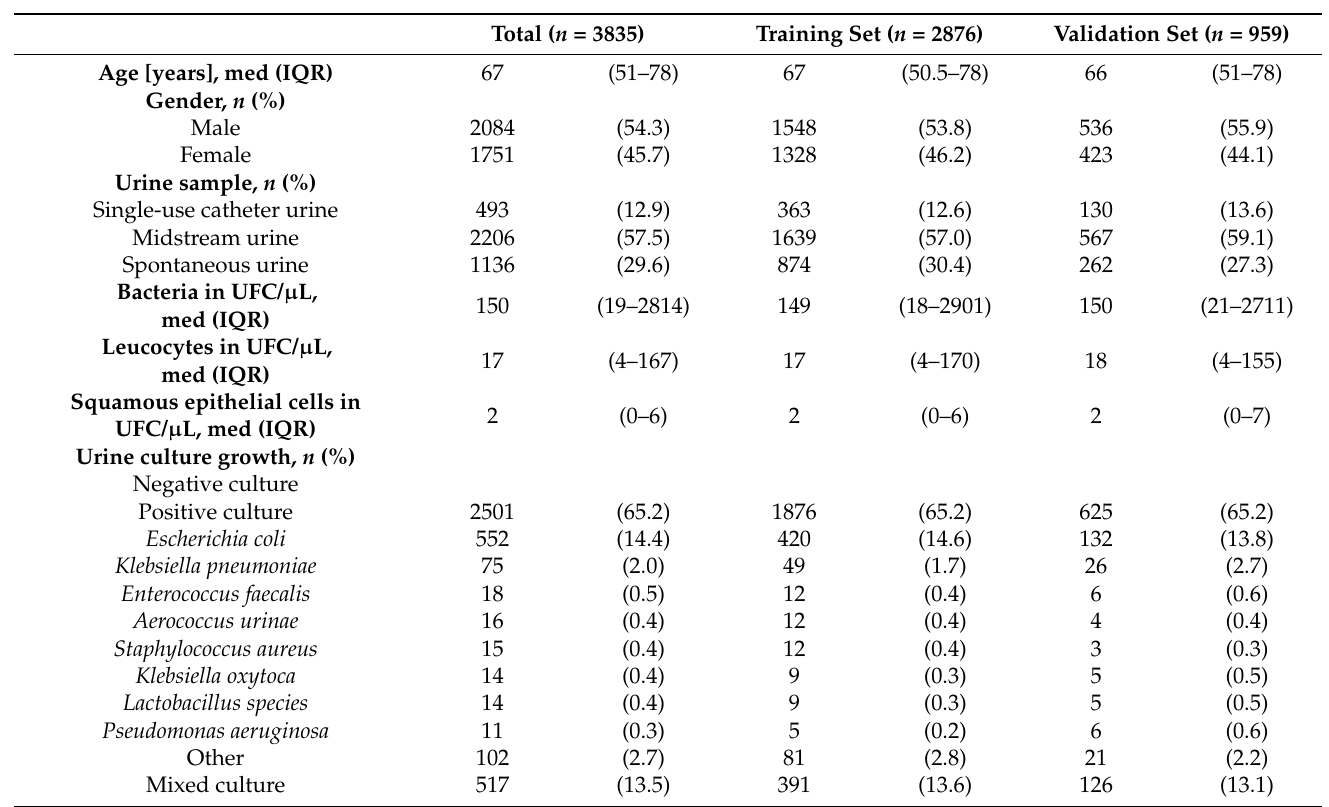
Table 1. Characteristics.